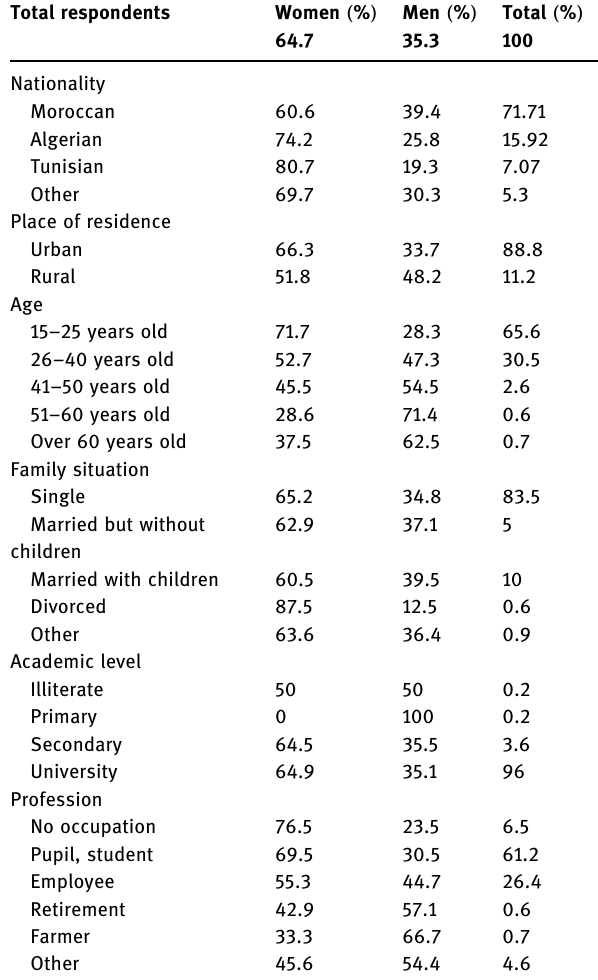
Table 1: Demographic pro fi le of the